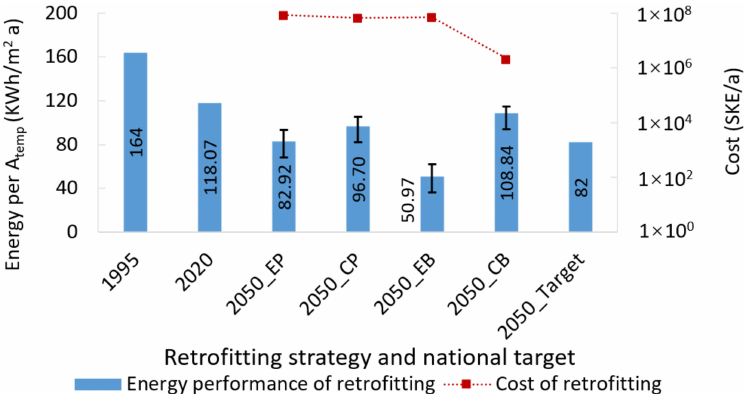
Figure 8. The energy and cost of Stockholm building stock under four retrofitting